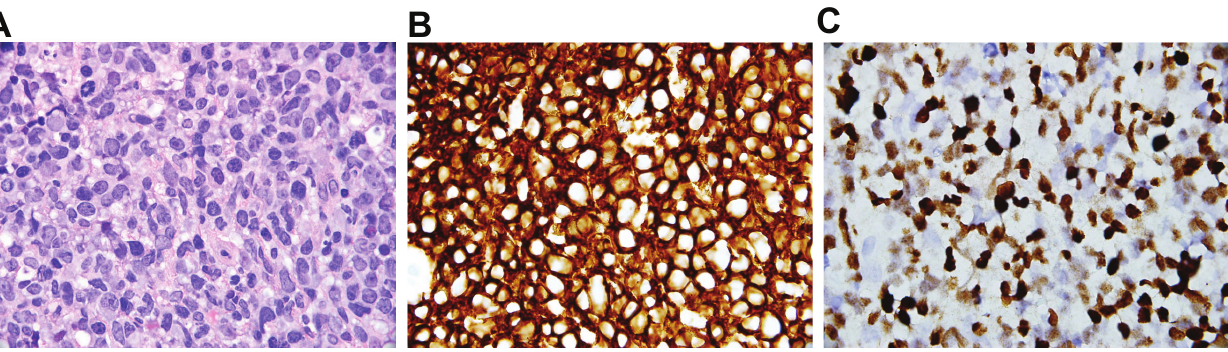
Figure 1. Biopsy of jejunal ulcer. 1A : Haematoxylin & Eosin stain, 1000x. Large, centroblastic lymphoid cells with hyperchromatic, pleomorphic nuclei and moderate cytoplasm. These tumor cells almost completely efface the jejunal mucosa. Scattered mitotic activity and apopotic debris are present as well. 1B : Immunohistochemical stain for CD20, 1000x. Diffusely positive membranous staining in the tumor cells is indicative of lymphoid differentiation. In the context of the morphology seen in Figure 1A , the findings are compatible with a Diffuse Large B-Cell Lymphoma (DLBCL). Per the 2008 World Health Organization (WHO) classification, a lymphoid proliferation that meets the criteria for a high grade malignancy (in this case DLBCL) that occurs in a recipient of a solid organ, bone marrow, or stem cell transplant is diagnostic of a post-transplant lymphoproliferative disorder (PTLD). 1C : In situ hybridization for Epstein-Barr virus encoded RNA (EBER), 1000x. Strong nuclear positivity is seen in the majority of the tumor cells, a finding seen in many monomorphic PTLD